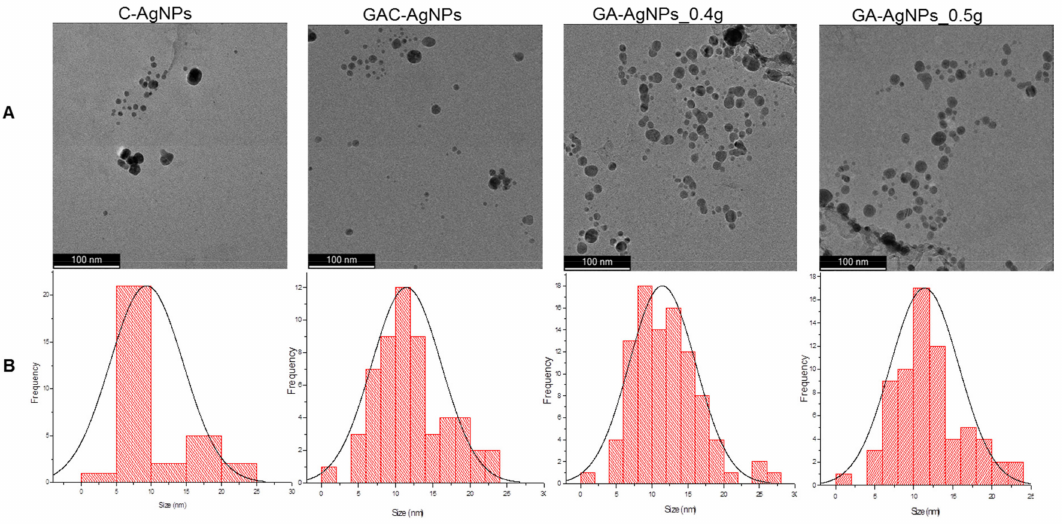
Figure 3. HRTEM micrographs of the AgNPs ( A ) and the AgNP core size distribution ( B ). DLS analysis revealed a hydrodynamic diameter range from 87.22 nm for the C-AgNPs to 94.62 nm for the GA-AgNPs to 144.39 nm for the GAC-AgNPs (Table 2). These